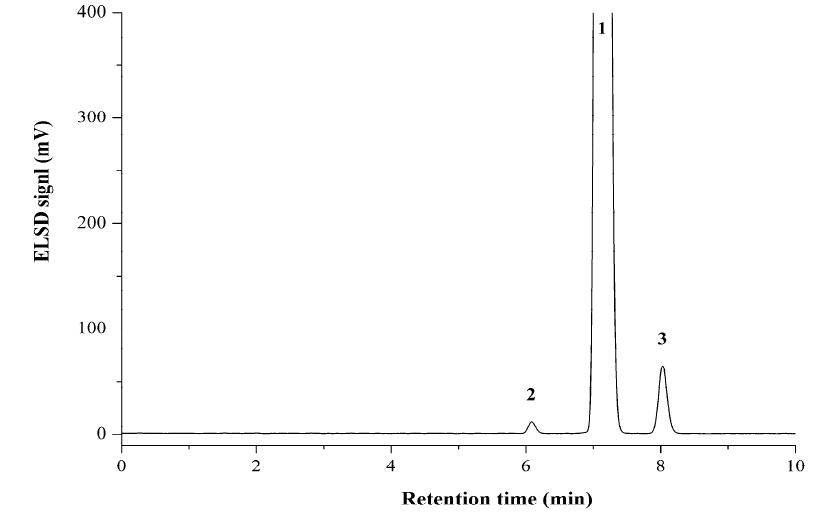
Figure 3. Typical HPLC-ELSD chromatogram of propionylbrassinolide technical concentrate on an Eclipse XDB-C 18 column (250 mm × 4.6 mm, 5.0 µ m) column. 1 : propionylbrassinolide; 2 : impurity 1;